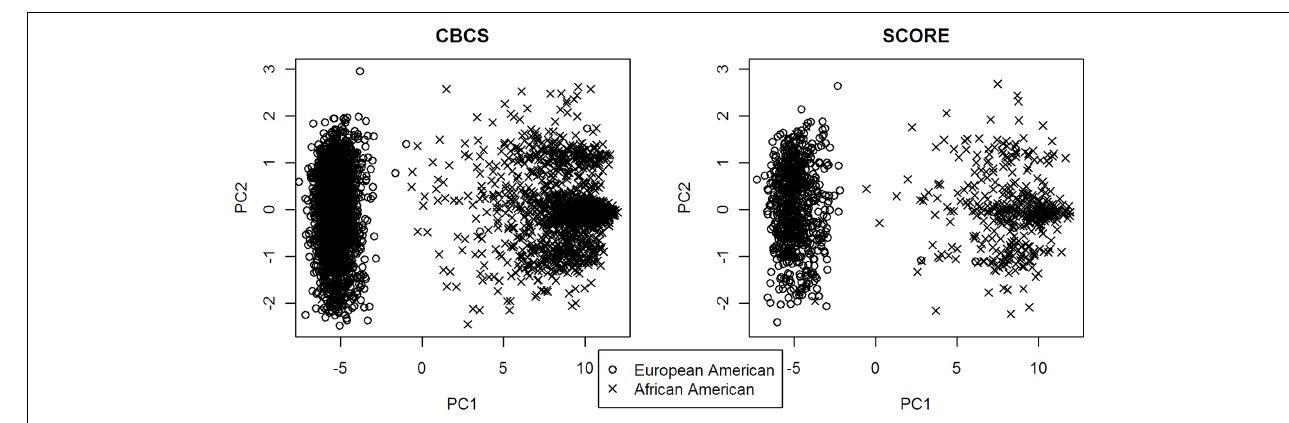
FIGURE 1 | Scatter plots of PC1 vs. PC2 for CBCS and